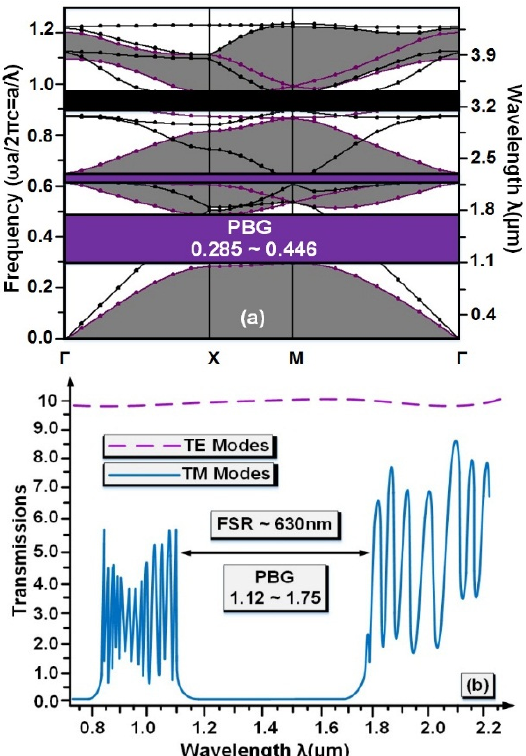
Figure 1. ( a ) Photon band diagram for polarization modes: TE and TM. ( b ) depicts the input pulse signal and determination of band gap range and resonant wavelengths. Table 1. Major parameters of the biosensor computed for different elements of blood. Analytic